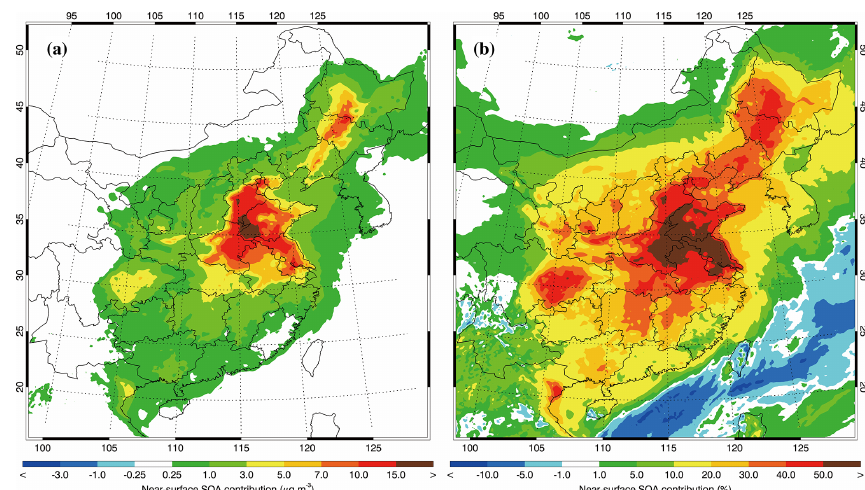
Figure 13. Average near-surface (a) absolute and (b) relative SOA contribution caused by the ALW-HET from 5 December 2015 to 4 Jan- uary 2016.